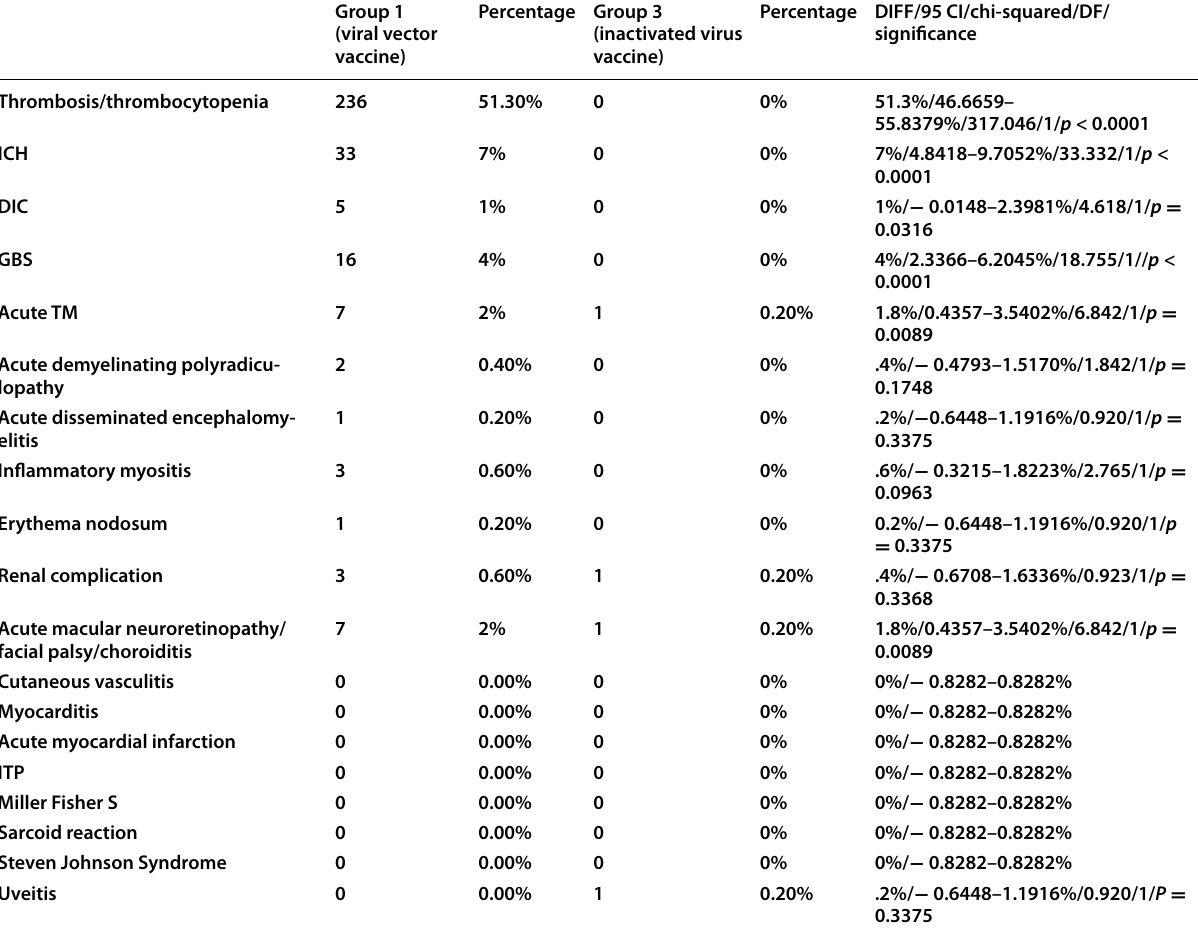
Table 4 Comparison between group 1 (pts received viral vector-based vaccines with adverse events) vs group 3 (pts received inactivated virus-based vaccines with adverse events)